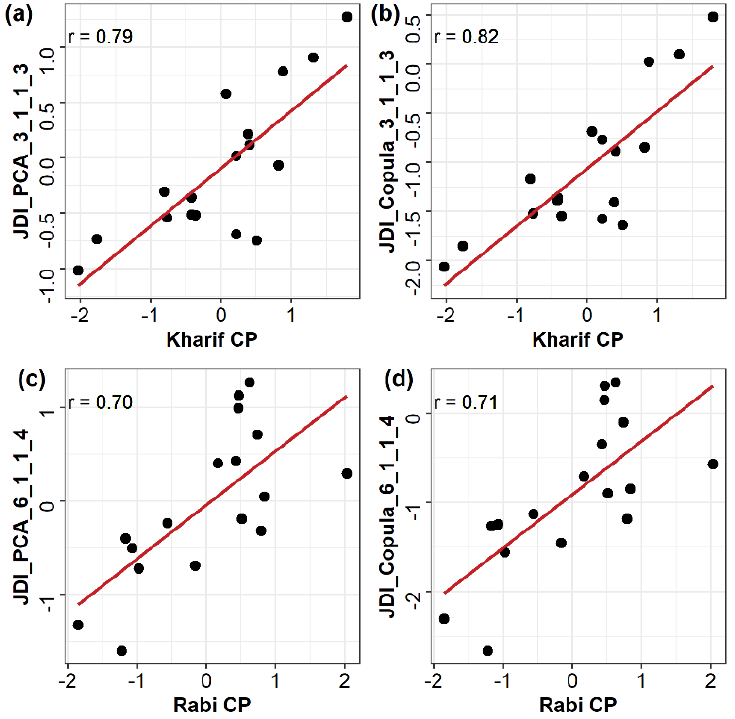
Figure 3. Correlation of mean drought intensity by JDI_PCA and JDI_Copula with the seasonal crop production (CP) in ( a , b ) Kharif season and in ( c , d ) Rabi season. The scales of the integrated indices in JDI_PCA and JDI_Copula in Kharif (3_1_1_3) and in Rabi (6_1_1_4) season are in the order of SPEI, SSI, SGI, and SRI.